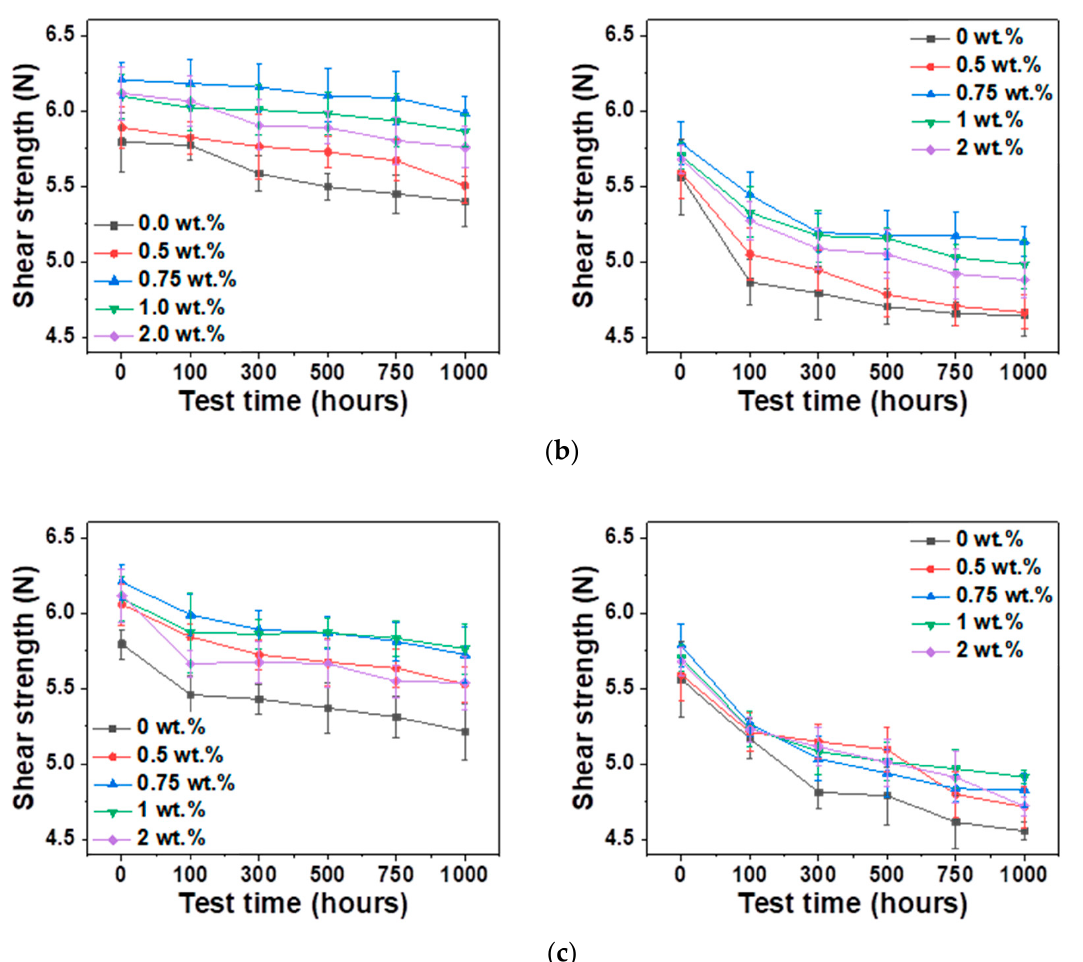
Figure 7. Shear strengths of Sn–58Bi composite solder joints with the test times and Ag NP contents after a high-temperature storage (HTS) tests at ( a ) 85 °C, ( b ) 100 °C, and ( c ) 115 °C .